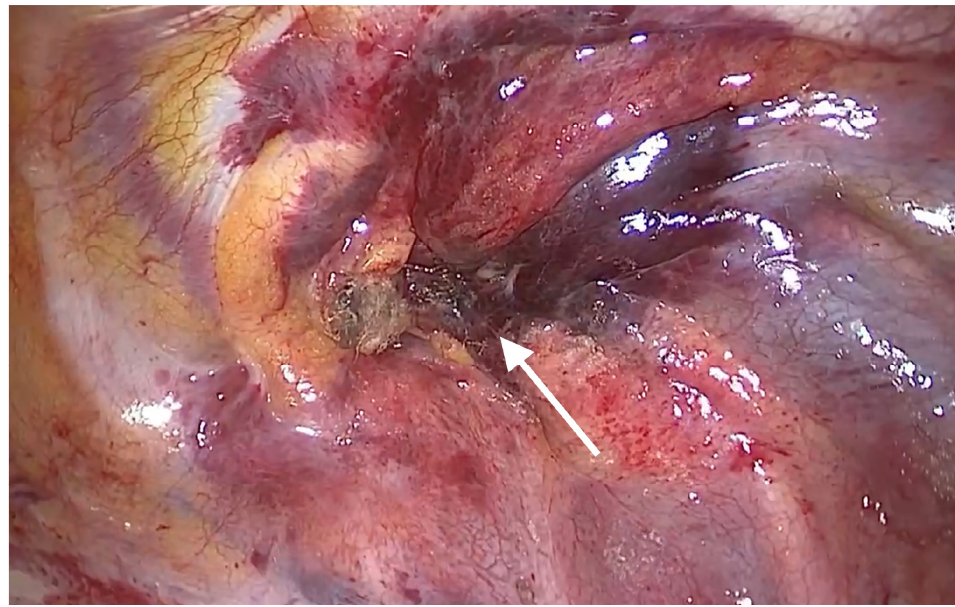
Figure 2. Intraoperative hemostasis at the site of perforation (arrow) of the superior vena cava.